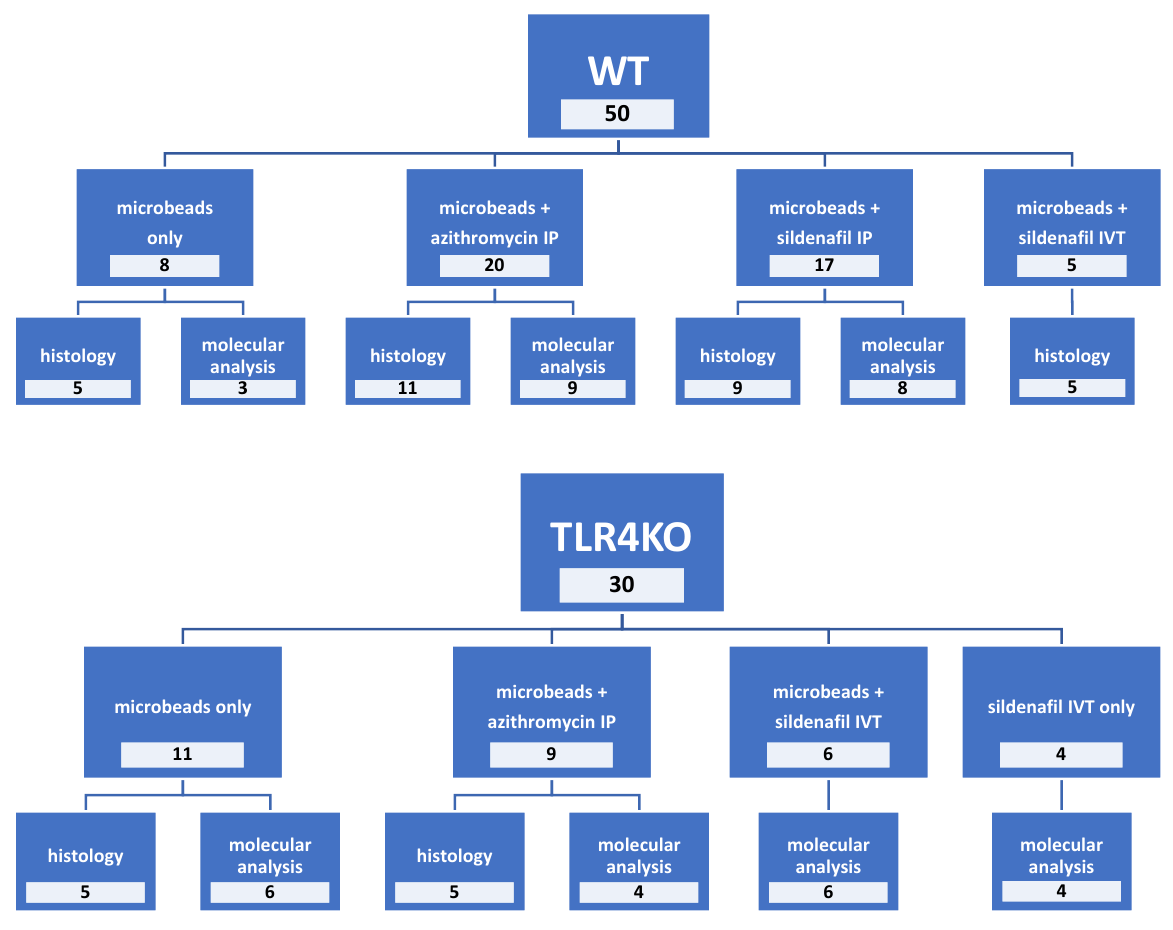
Figure 10. Research group allocation. The figure describes the different procedures and number of mice in each intervention group. Local interventions, including microbead injection, intravitreal azithromycin, or intravitreal sildenafil injections, were given to the right eye only. Both eyes under- went histological or molecular examination. IP, intraperitoneal; IVT, intravitreal; TLR4KO, toll-like receptor 4 knockout; WT, wild type.